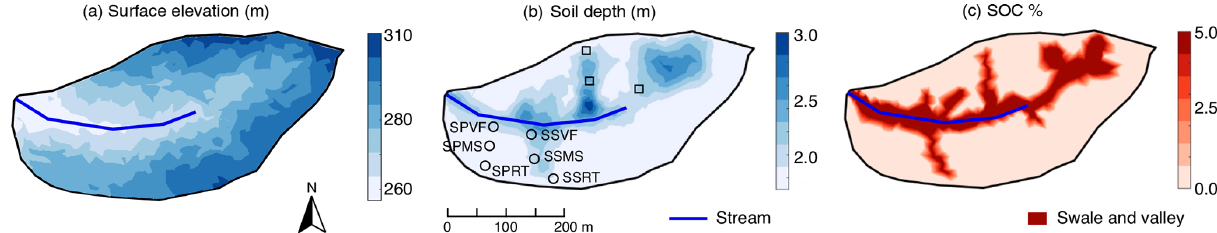
Figure 1. Attributes of the Susquehanna Shale Hills Critical Zone Observatory (SSHCZO): (a) surface elevation, (b) soil depth, and (c) soil organic carbon (SOC). The surface elevation was generated from lidar topographic data (criticalzone.org/shale-hills/data), whereas soil depths and SOC were interpolated using ordinary kriging based on field surveys with 77 and 56 sampling locations, respectively (Andrews et al., 2011; Lin, 2006). The SOC distribution in panel (c) is further simplified using the high, uniform SOC (5% v/v ) in swales and valley soils based on field survey information (Andrews et al., 2011). Swales and valley floor areas were defined based on surface elevation via field survey and a 10m resolution digital elevation model (Lin, 2006). Additional sampling instrumentation is shown in panel (b) , including six soil water sites (circles) and three soil T sites